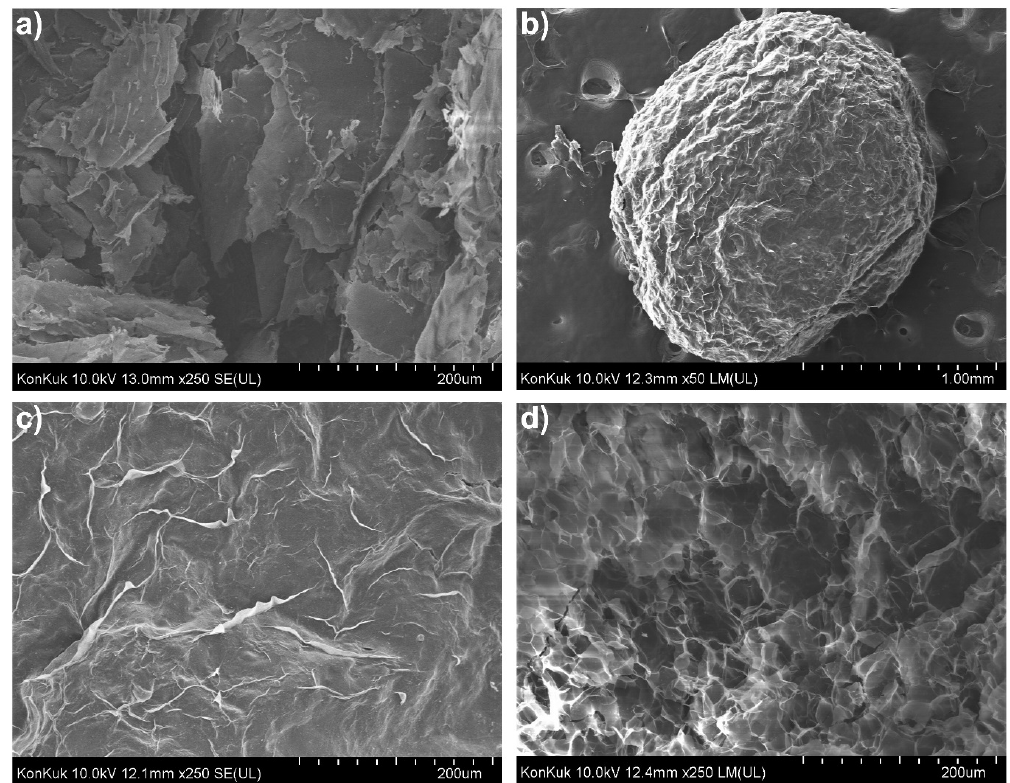
Figure 6. SEM images of succinoglycan ( a ), surface morphology of Fe 3+ -SG hydrogel beads in the dry state ( b ), dried Fe 3+ -SG hydrogel beads under 250× magnification ( c ), and the cross-sectional images of the Fe 3+ -SG hydrogel beads ( d ).